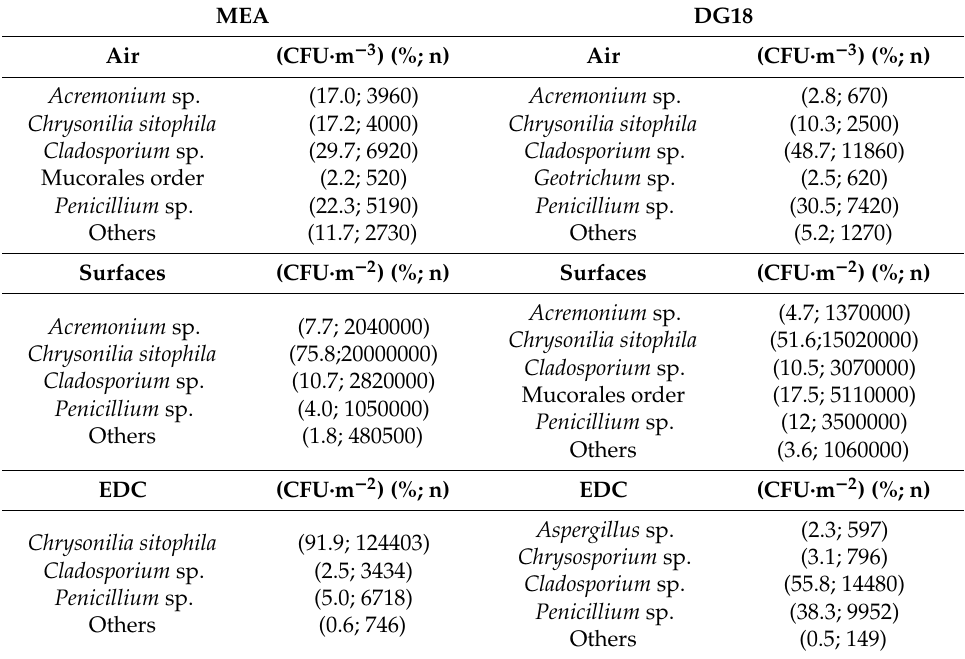
Table 4. Fungal distribution on the collected environmental samples after inoculation onto MEA and DG18